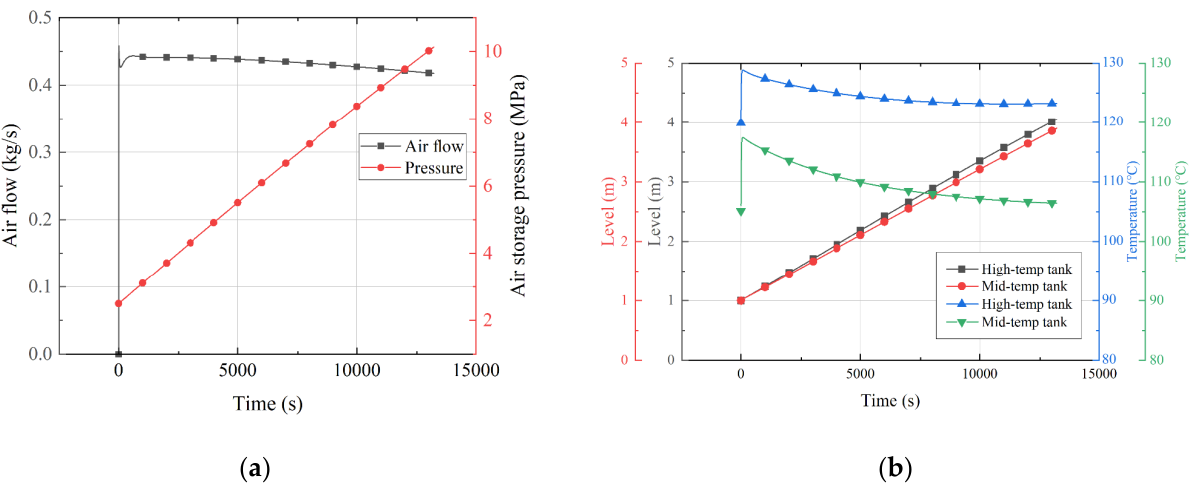
Figure 5. Energy storage process of the AA-CAES model. ( a ) air storage; ( b ) tanks.